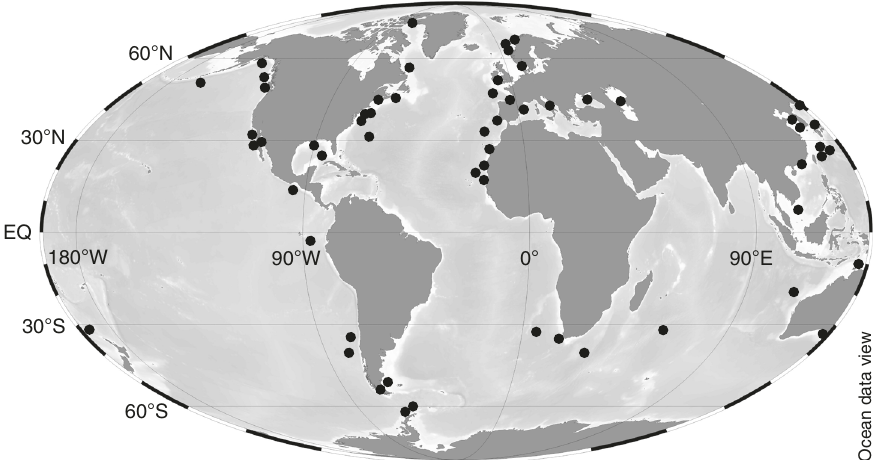
Fig. 6 Biogeographical distribution of Minidiscus across ocean basins. Information regarding the biogeographical distribution of Minidiscus spp. was